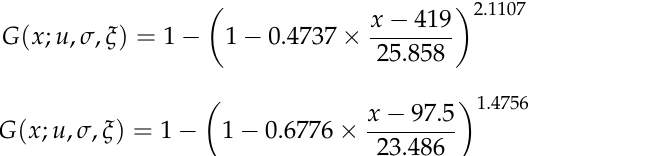
Table 2. Generalized Pareto Distribution (GPD) fitting result.